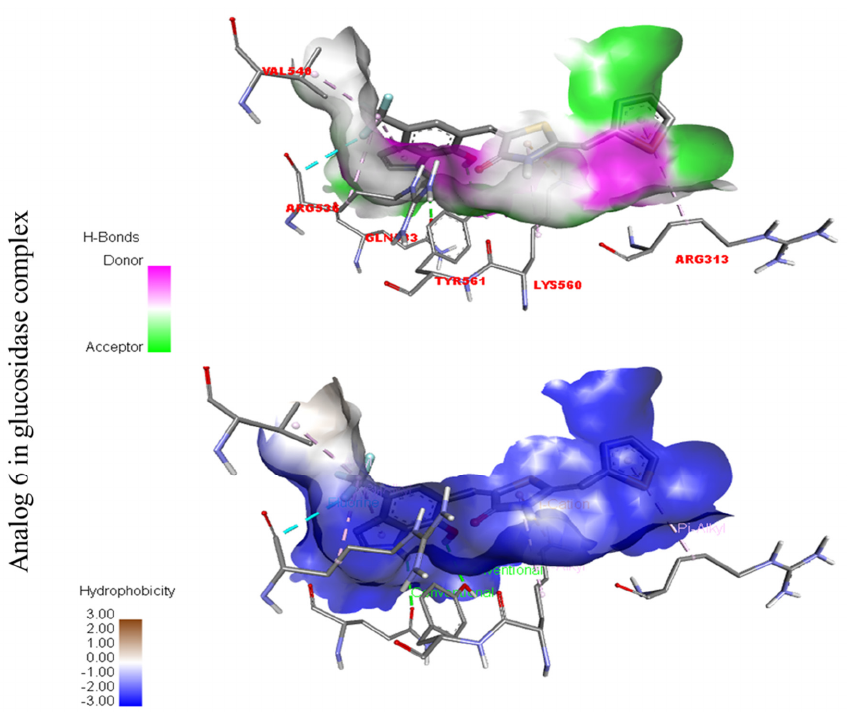
Figure 11. Represent hydrogen bond and hydrophobic character against Alpha-glucosidase indicate the PLI profile for compound 6. The third most potent compound seven in the series illustrated comparable activity with analogs four and five having better interaction profiles. Analog seven contains nitro moiety which showed different interactions against Alpha-amylase (G) with distance from 3.68–5.94 A, such as PHE-A-335( π - π -stacked), PRO-A-4( π -R), ASP-A-402( π -anion), GLY-A-403( π - π -T-shaped), GLN-A-8(H-B), etc., as shown in (Figure 12). While those against Alpha-glucosidase (H) had distances from 4.19–7.09 A, including ASP-A-232(H- B), ARG-A-552(H-B), TRP-A-432( π - π -T-shaped), TRP-A-329( π - π -T-shaped), ASP-A- 469( π -anion), ALA-A-234( π -R), etc., as shown in (Figure 12).